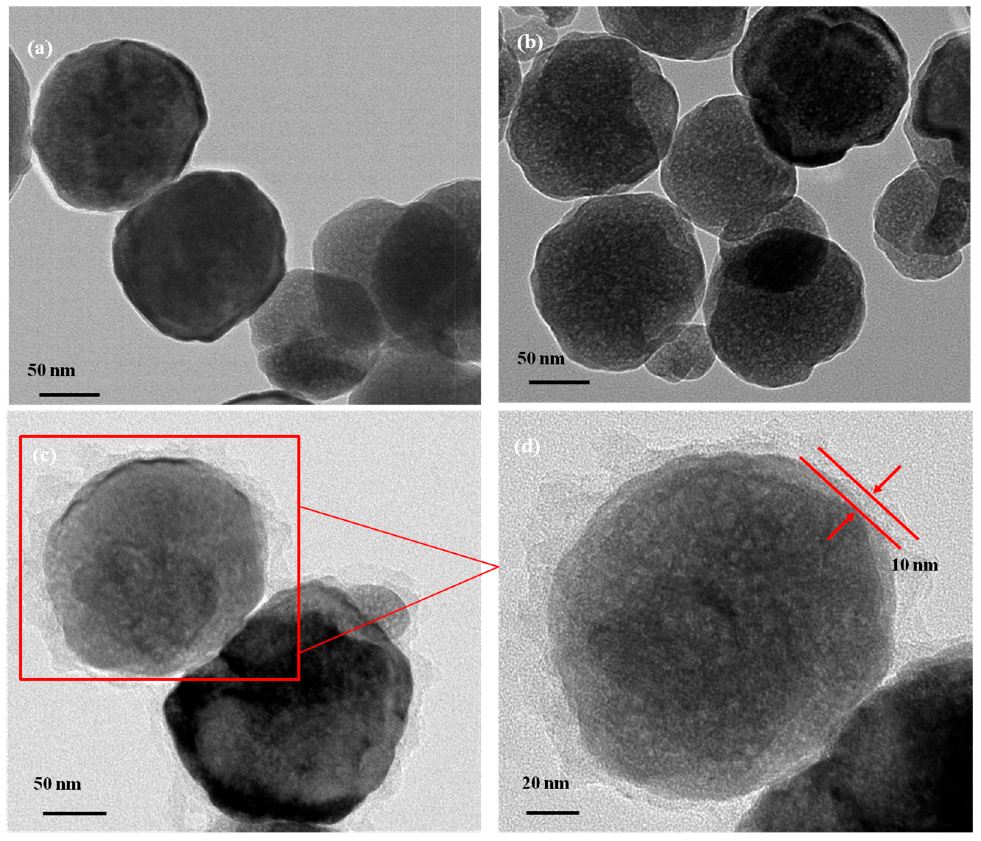
Figure 1. Transmission electron microscope (TEM) image of ( a ) Fe 3 O 4 , ( b ) γ -MPS-Fe 3 O 4 , and ( c , d ) Mag-PVP.